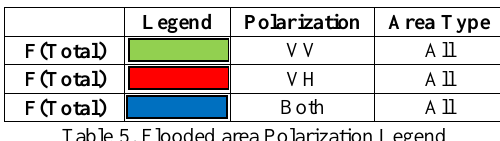
Figure 6. Cross Polarization effect over flooded area